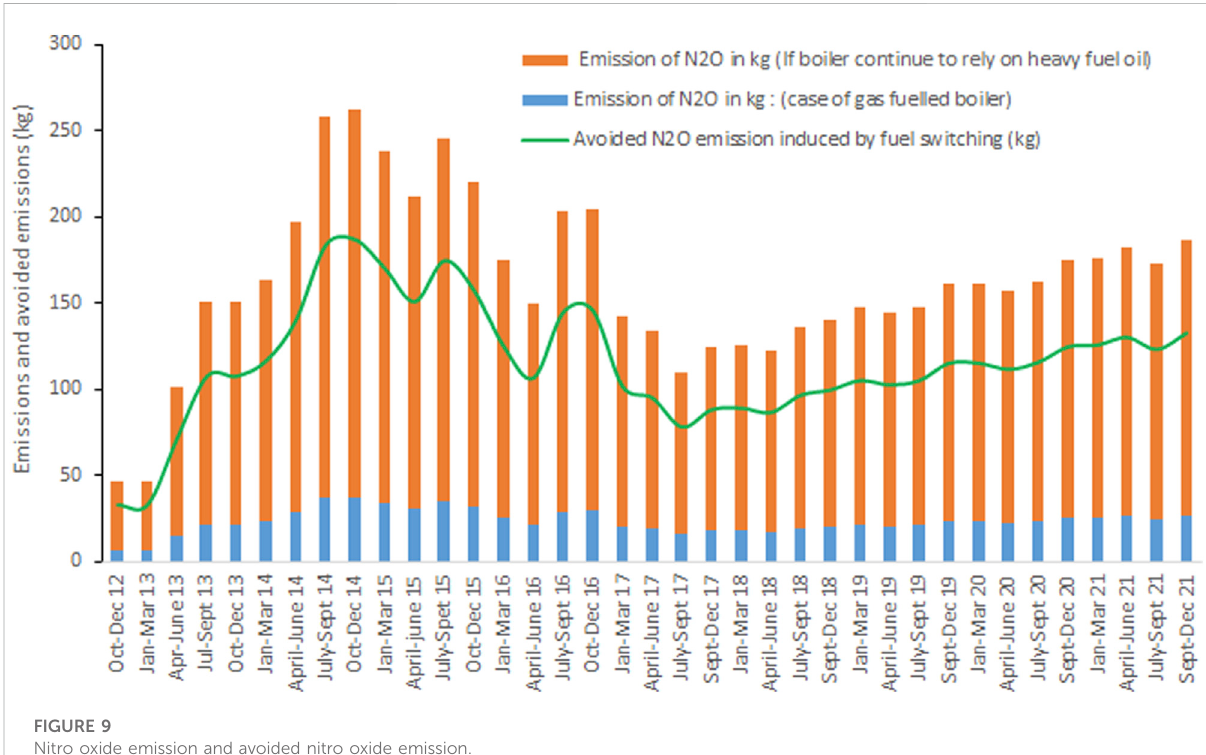
FIGURE 9 Nitro oxide emission and avoided nitro oxide